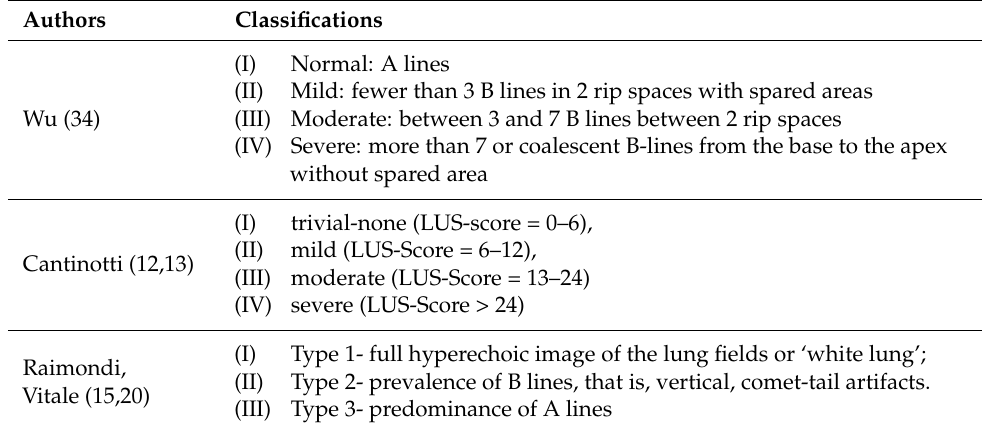
Table 1. Major semiquantitative scores for lung congestion classification in